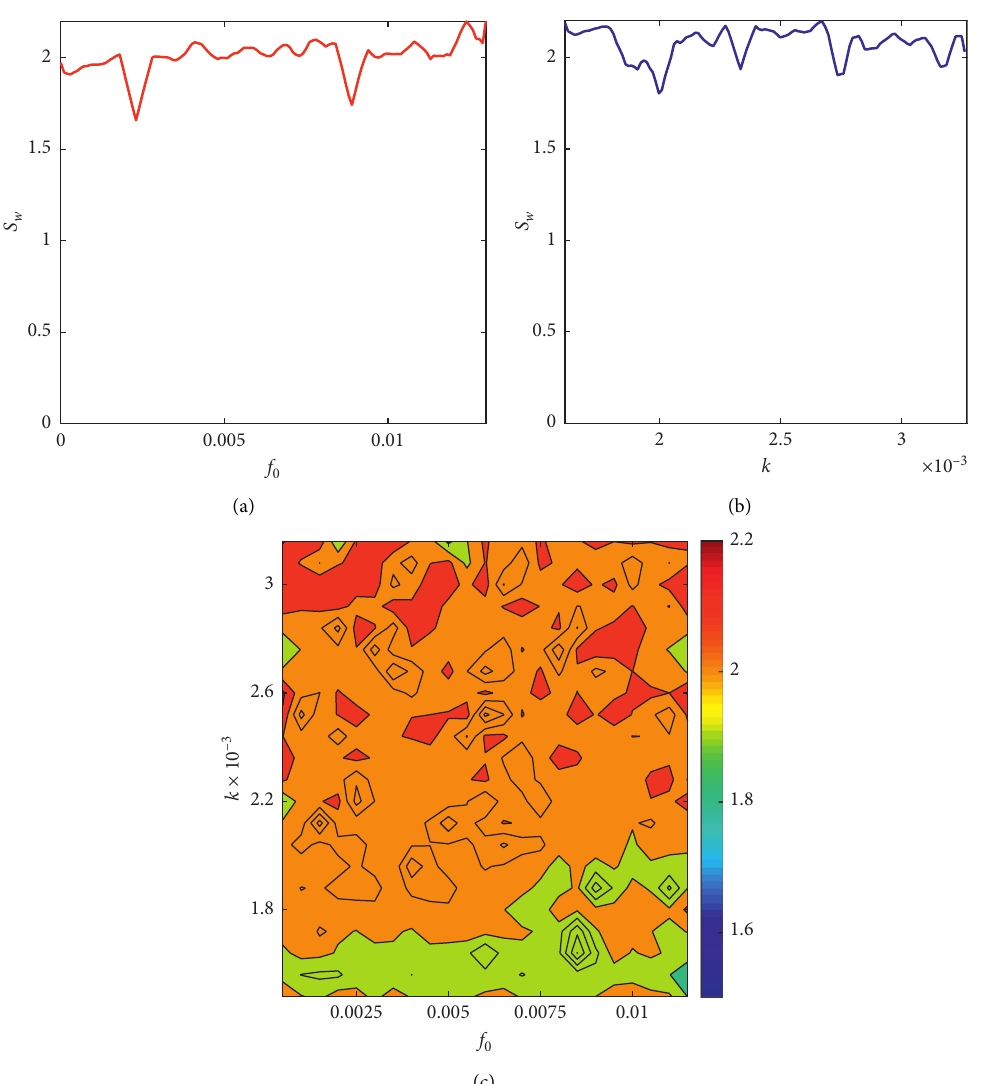
Figure 7: (a) and (b) represent [ w ( i,j )] matrix plots for system (13) with f � 0 . 001 and 0.012, respectively. In order to calculate [ w ( i,j )] 0 matrix, we solve system (13) with the initial condition ( 0 , − 0 . 0032 ) . Same plots are represented in (c) and (d) with respect to the different � 0 . 012. In both the cases, the values of parameters are considered same, as initial conditions ( 0 , − 0 . 00161 ) and ( 0 , − 0 . 00261 ) , for fixed f 0 chosen in Figure 2. In each calculation, we consider last 10,000 points on the